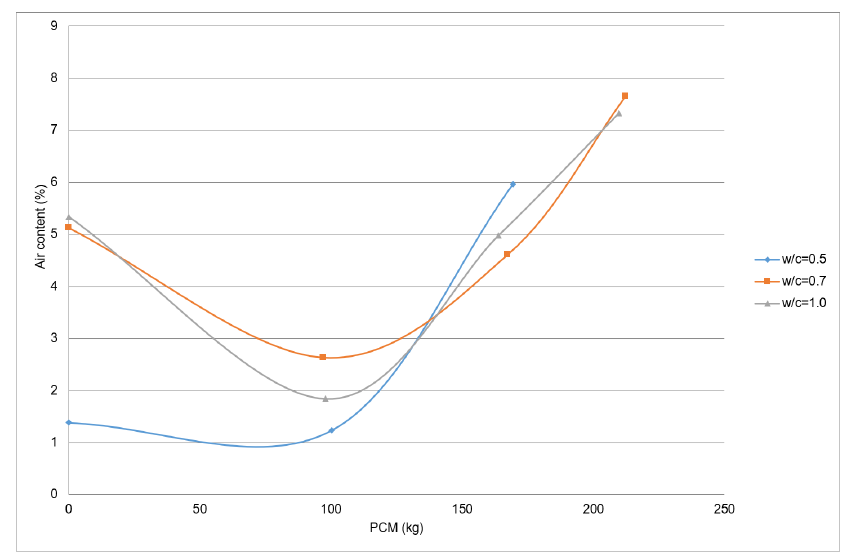
Figure 9. Air content in PX27 and CEM I 42.5